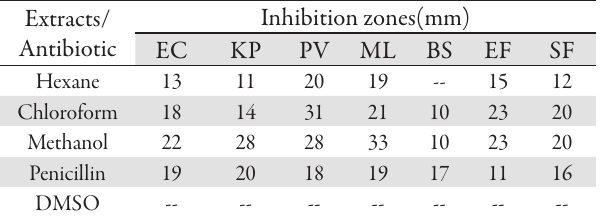
Tab. 1. Inhibitory zones of extracts of Azadirachta